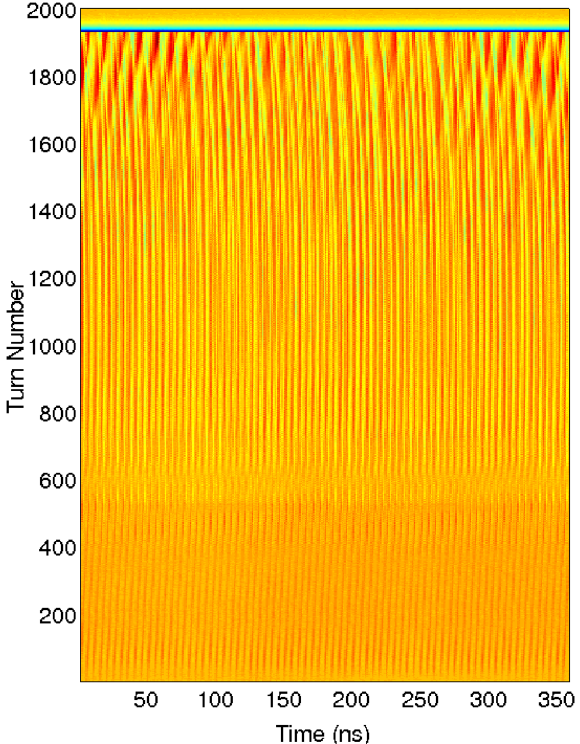
FIG. 2. (Color) Waterfall plot of the wall current monitor signal for the unchopped beam experiment. The time in a single pulse is plotted on the horizontal axis, and the turn number is plotted on the vertical axis. Beam injection ends at 559 turns. The high frequency variations in color indicate the microbunch structure of the